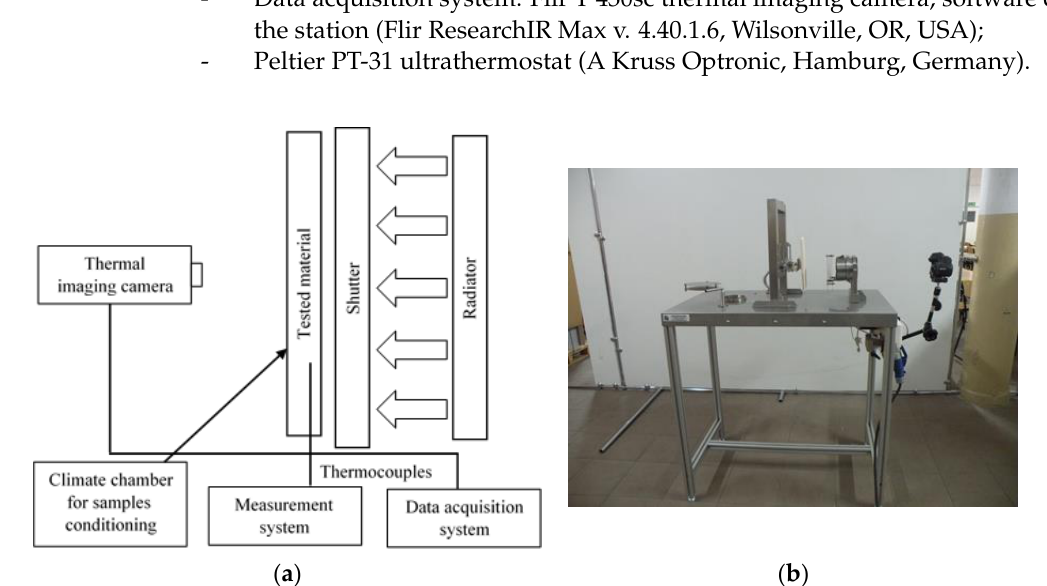
Figure 12. Heat radiation testing stage: ( a ) block scheme; ( b ) real photo.